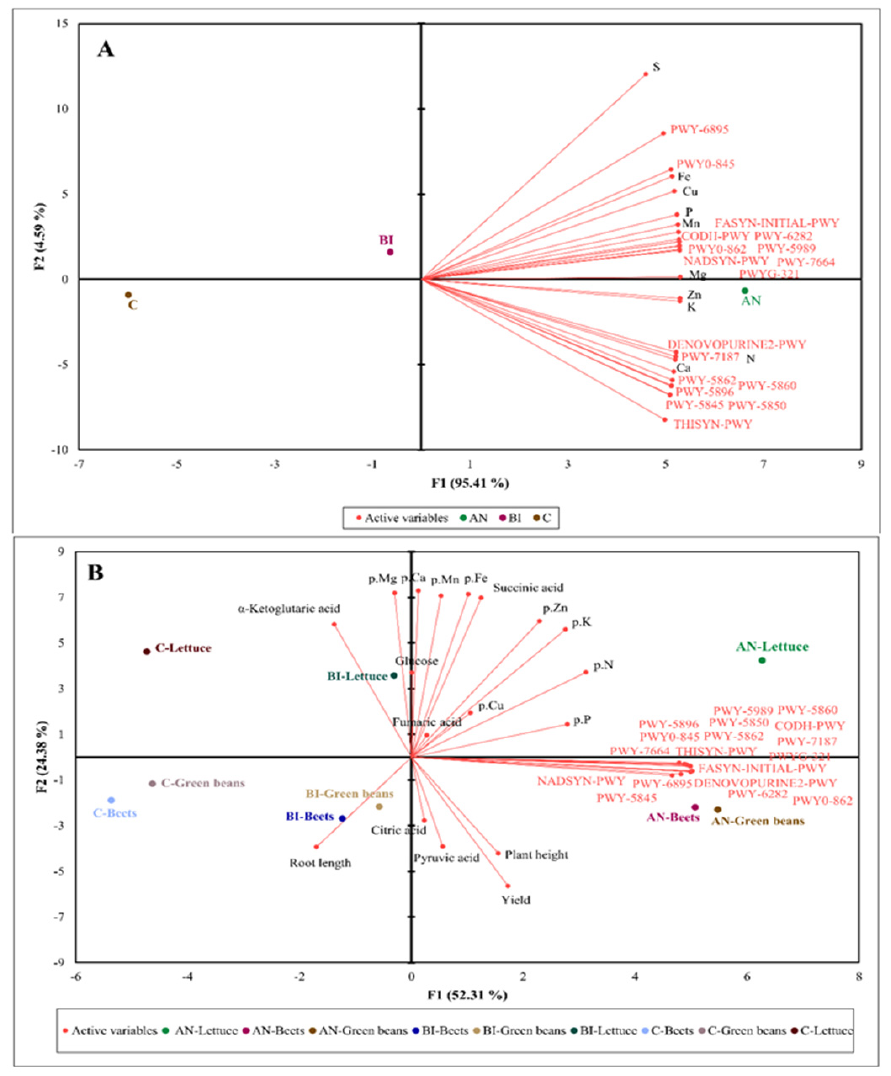
Figure 5. Multivariate analysis using principal component biplot. ( A ): shows association amongst municipal solid waste compost application frequency, soil elements and soil microbial function. ( B ): shows association amongst crop species, growth and yield components, plant tissue elements, tricarboxylic acid cycle metabolites and soil microbial function. AN, BI, and C are annual, biennial and no compost application, respectively. S, sulphur; Fe, iron; Cu, copper; P, phosphorus; Mn, manganese; Ca, calcium; N, nitrogen; Zn, zinc; K, potassium; Mg, magnesium. p represent plant tissue.